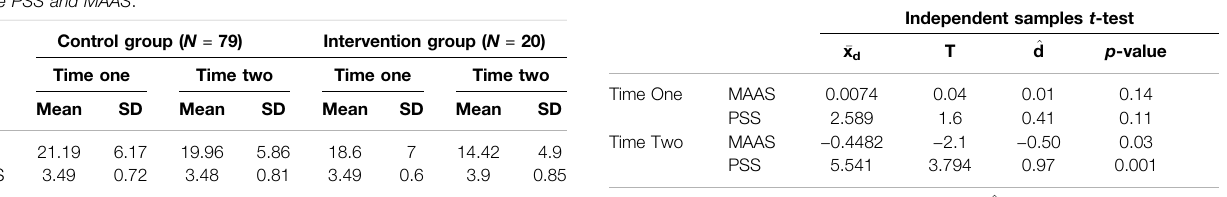
TABLE 10 | Independent Sample t-test Results Summary a